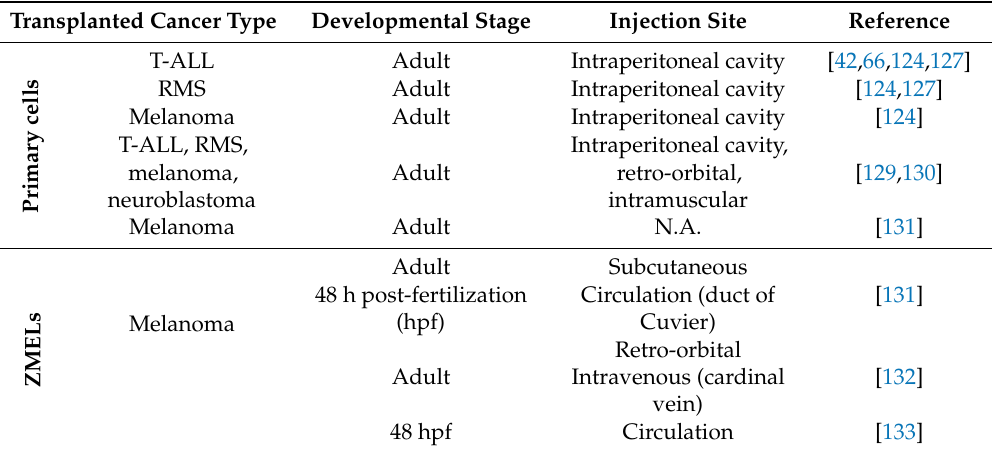
Table 3. Cancer allograft transplantation models in